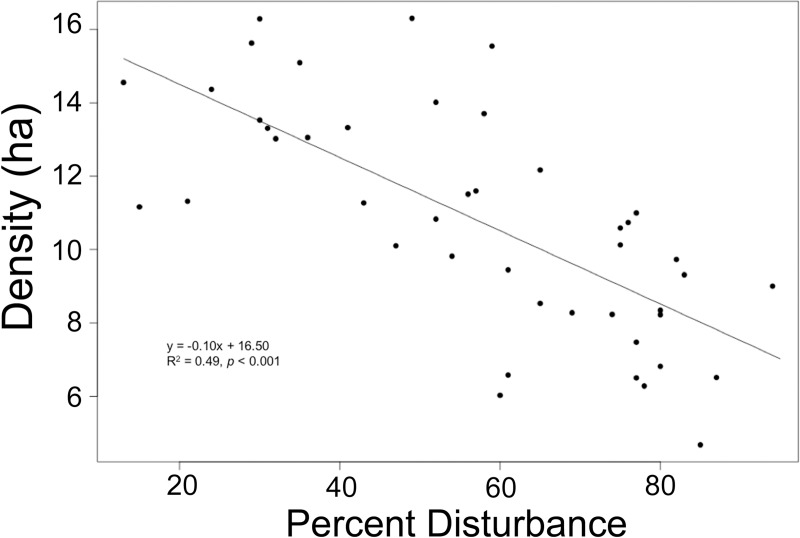
Species richness decreases significantly with increasing percent disturbance.The relationship between tree species richness and percent forest disturbance in 44 church forests in northern Ethiopia.